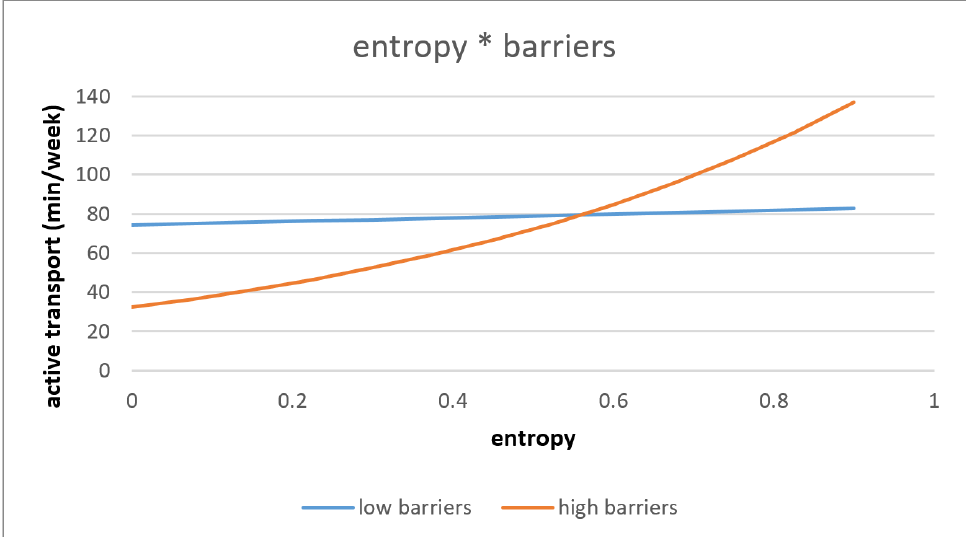
Figure 5. Interaction effect of entropy and barriers towards PA on active transport. The association between objective entropy and AT was significantly moderated by benefits towards PA ( p = 0.015). Only for older adults with low benefits towards PA there was a difference depending on the entropy index of the neighborhood on AT. Older adults living in low entropy index neighborhood with low benefits towards PA performed less AT in comparison to older adults with high benefits towards PA. While older adults living in high entropy index neighborhood with low benefits towards PA did more AT in comparison to older adults with high benefits towards PA (see Figure 6).